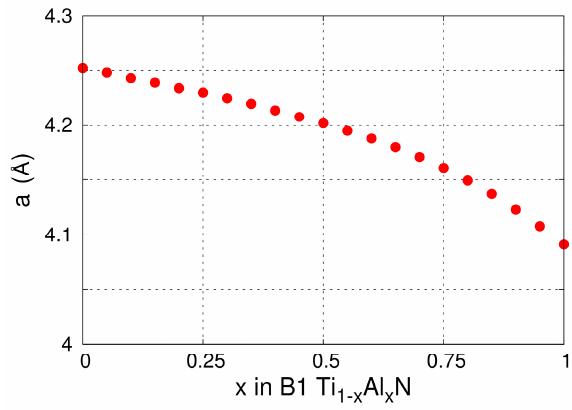
Figure 1. MEAM-predicted lattice parameter a of B1-Ti 1 − x Al x N (0 ≤ x ≤ 1) as function of x.